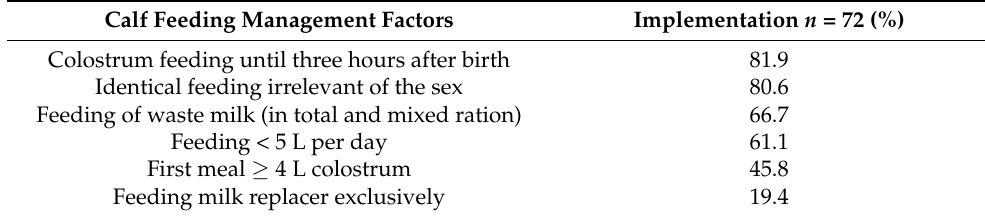
Table 3. Percentages of farms implementing selected common practices regarding calf feeding.